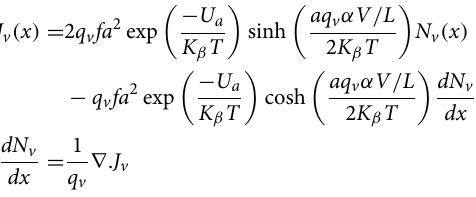
a sweep cycling mode with a step of 0.05 V. + 3 V and − 1 V was applied onto the Cu electrode to set and reset